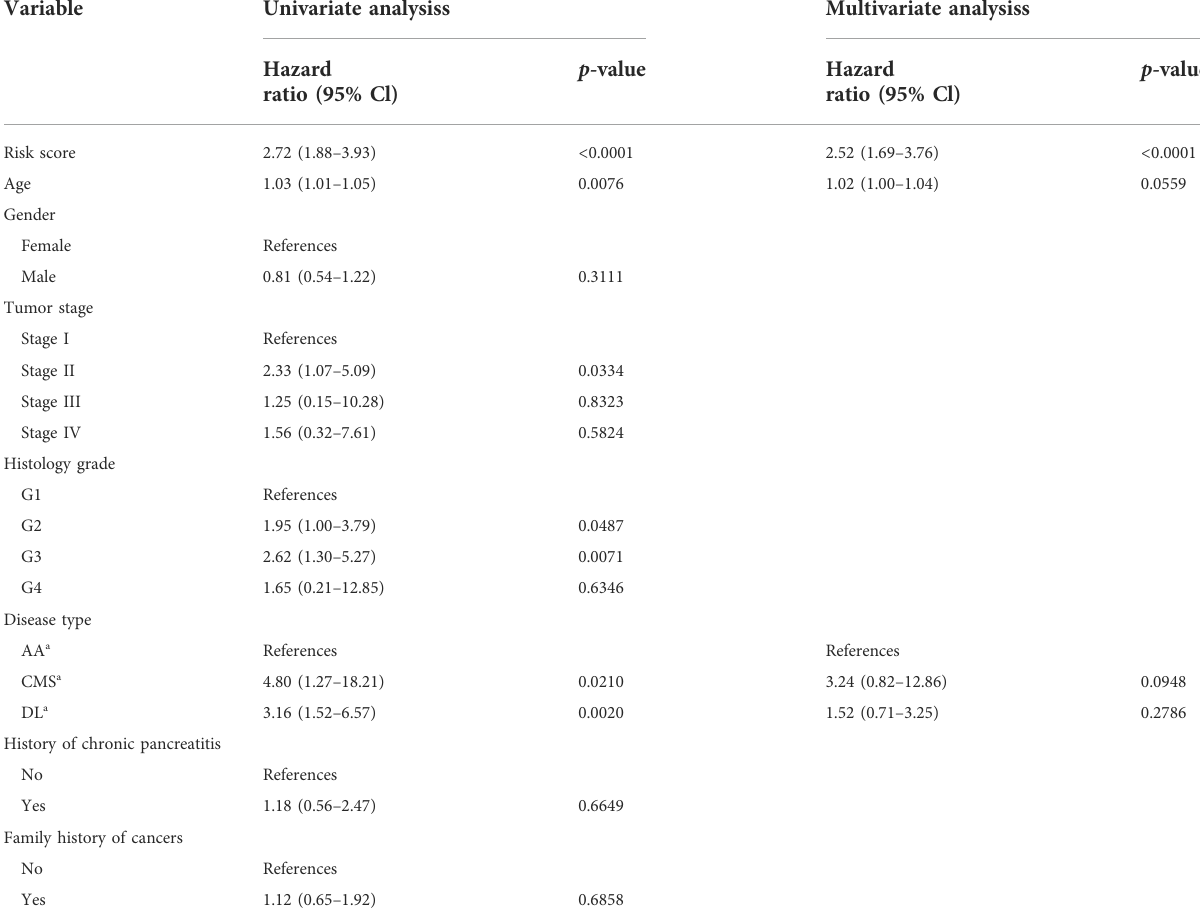
TABLE 2 Univariate and multivariate cox regression analysis for prognostic model and clinical